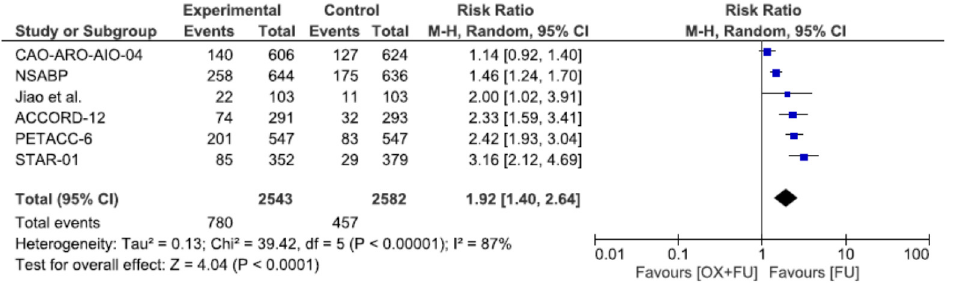
Figure 7. Forest plot of risk ratio for grade 3 or 4 toxicity.